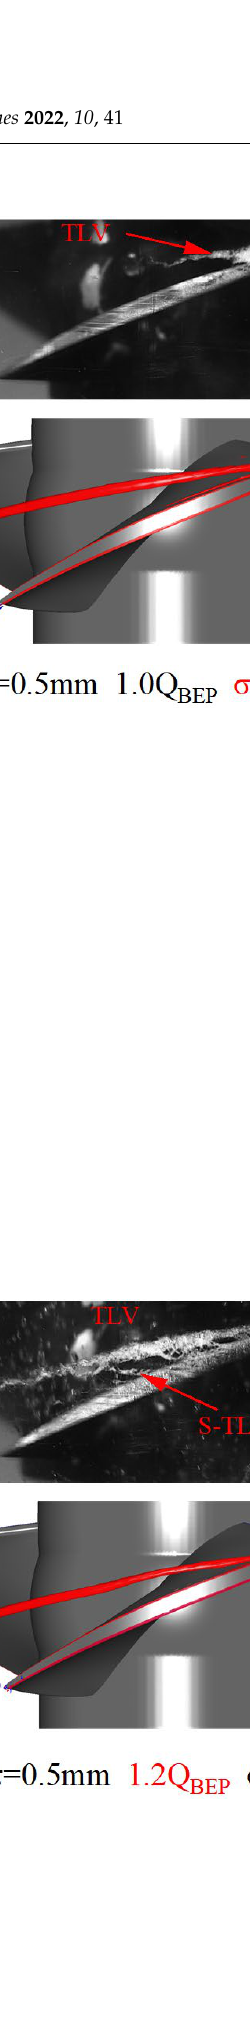
Figure 23. Cavitation images and vortex isosurface (Liutex R = 1000, Red ─ circumferential vortex, Blue ─ axial vortex) under different flow rates.